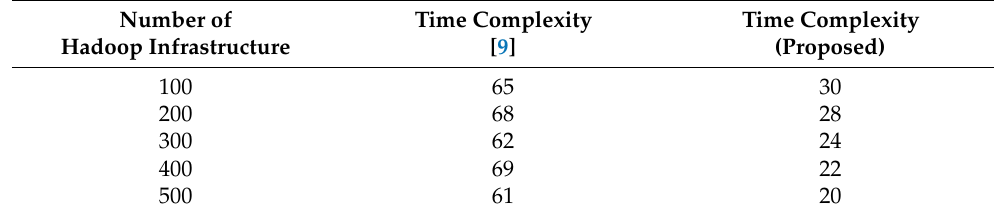
Table 8. Comparison of time complexities.